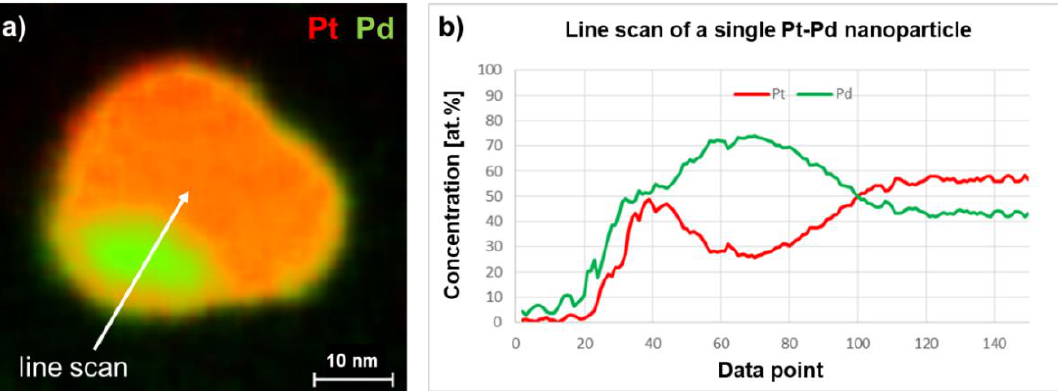
Figure 5. Representative EDXS line scan of a single Pt-Pd particle after aging for 16 h at 750 °C with an overview on the elemental composition of the bimetallic particle ( a ) and the detailed elemental concentrations along the line scan ( b ).